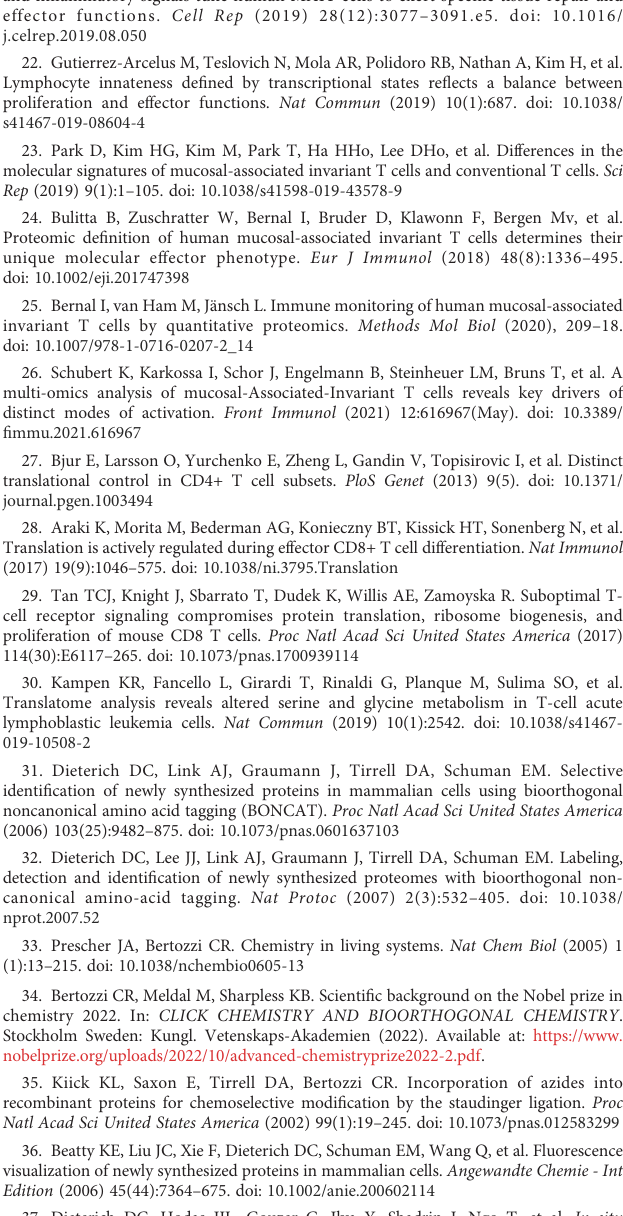
SUPPLEMENTARY TABLE 2 Bicellular_THP-1. SUPPLEMENTARY TABLE 3 Monocellular_MAIT.